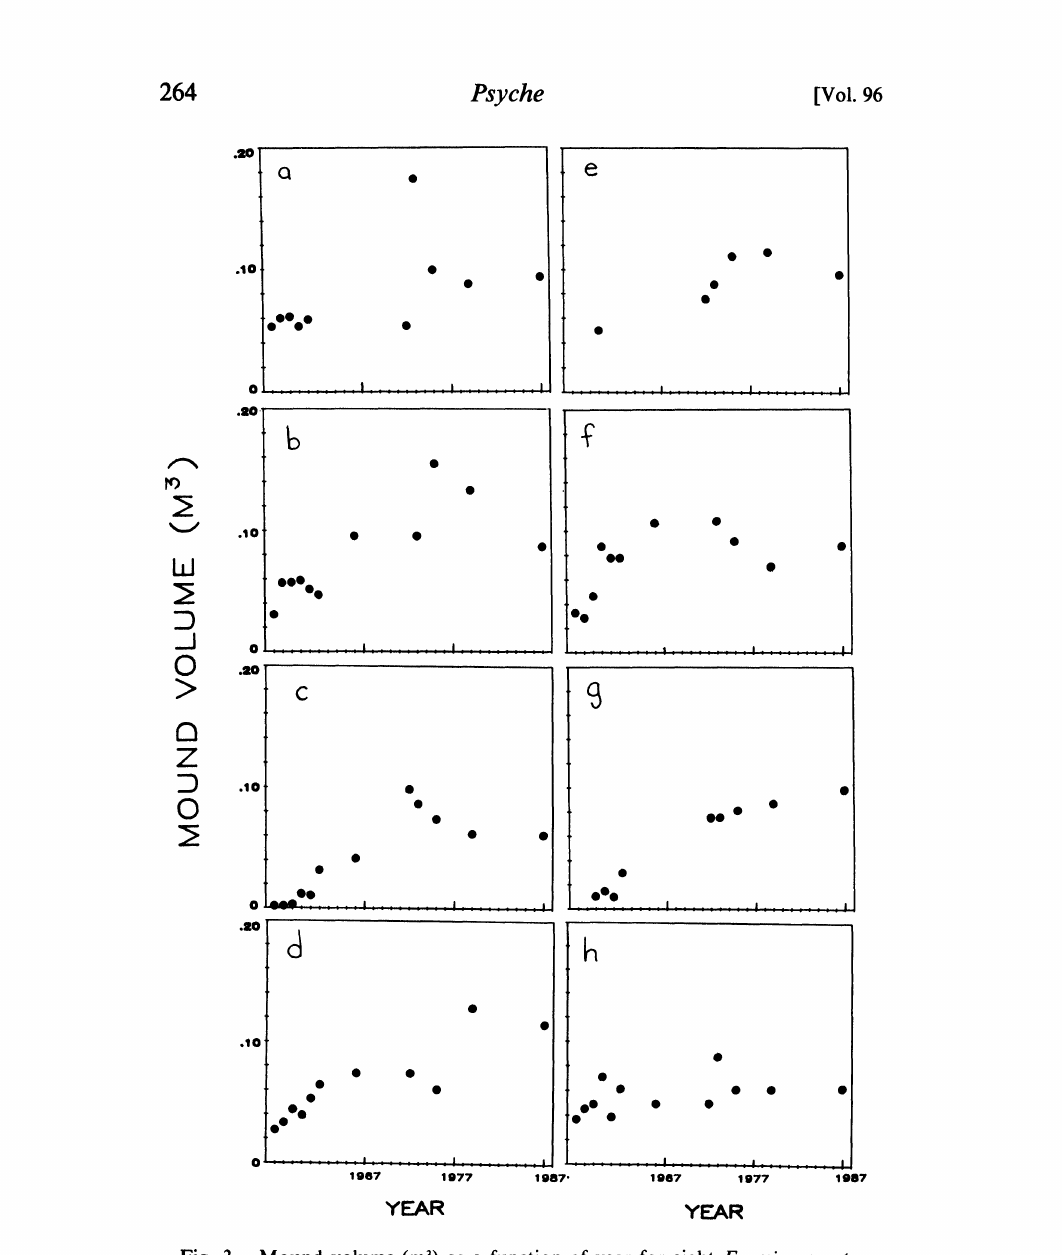
Fig. 3. Mound volume (m3) as a function of year for eight Formica montana colonies censused over a 3 l-year